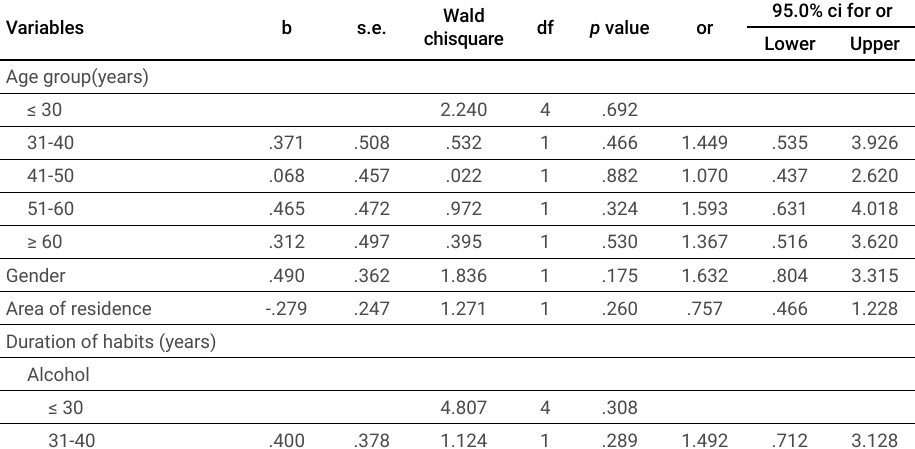
Wald df p value or chisquare